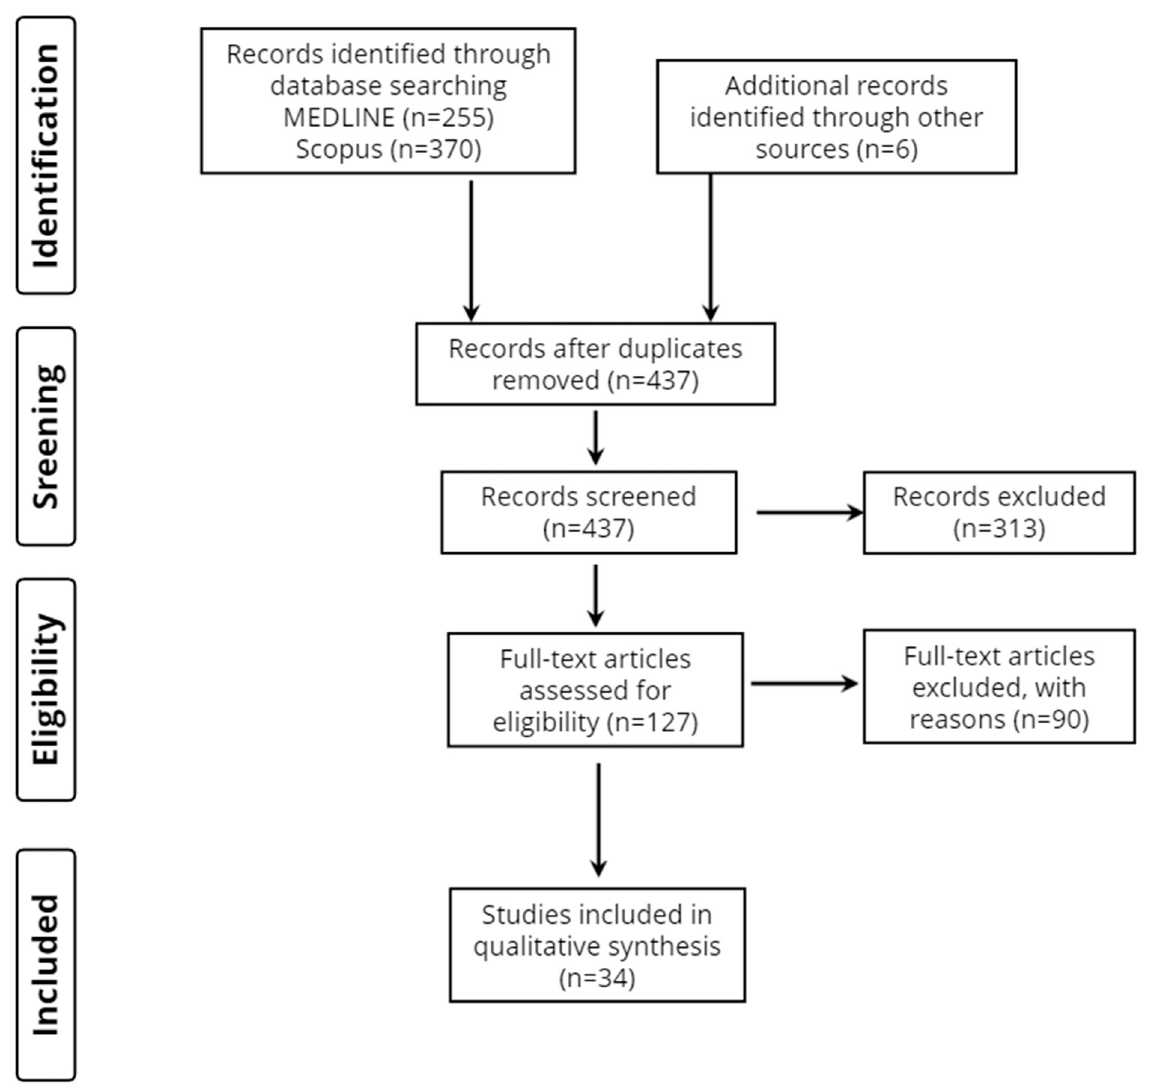
Figure 1. Study flow diagram (PRISMA flowchart).